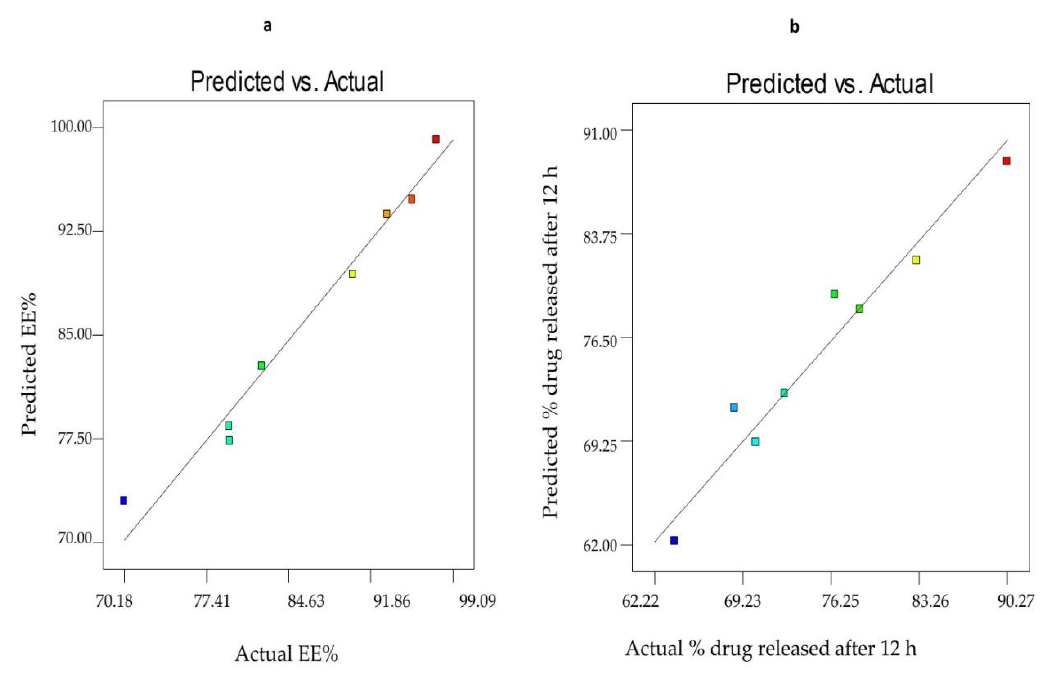
Figure 4. Linearity plots of SV-loaded SNVs shown as observed versus predicted values for ( a ) % EE and ( b ) Q 12h . Abbreviations: SV, Sodium valproate; SNVs, spanlastic nanovesicles; EE, entrapment efficiency; Q 12h , % drug released after 12 h.